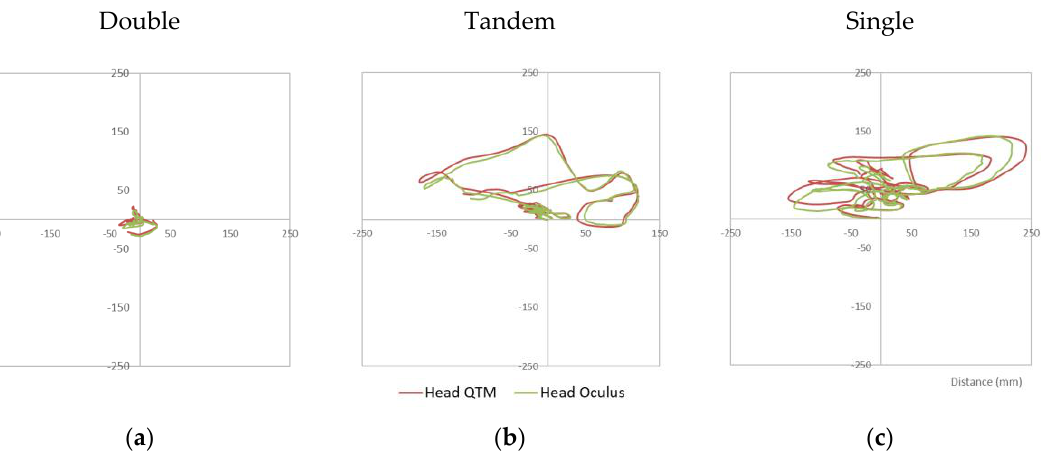
Figure 2. Three stabilogram plots representing the head sway (distance in mm) captured by the Oculus Quest (green) and the Qualisys motion capture cameras (red) in the three different stances (Double ( a ), Tandem ( b ), Single ( c )) in two different axes (AP and ML). (ICC) and Root Mean Square Errors (RMSE) were calculated for the head movement data.